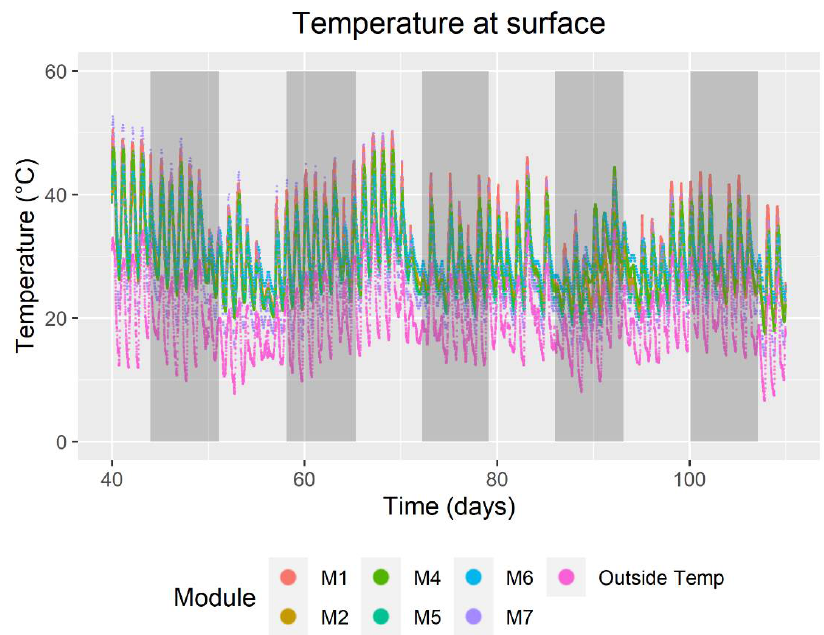
Figure 8. Temperature at surface during the full-scale test within the trial field. Grey highlighted are the conducted air breaches. Breaches 1–3 and 5 are at spot A, breach 4 is at spot B (Figure 2). It becomes obvious that outside temperature (pink) is always lower than surface temperature inside the silage. Nevertheless, the silage surface temperature shows a similar course to the outside temperature. As Module 8 broke within the first few days, it is not shown.